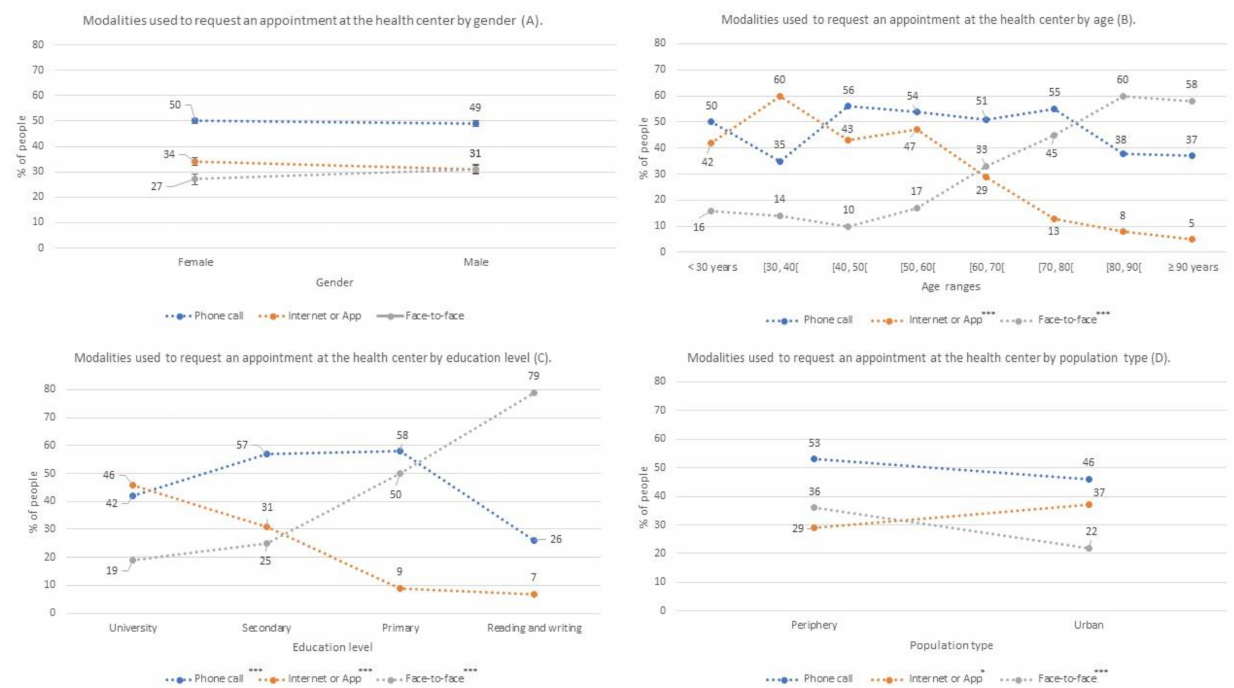
Figure 2. Percentages of participants who used each of the means to request an appointment at the health center (face-to-face, telephone or internet); Modalities used to request an appointment al the health center by gender ( A ); by age ( B ), by educational level ( C ) and by population type ( D ) *: p -value < 0.05; ***: p -value < 0.001.